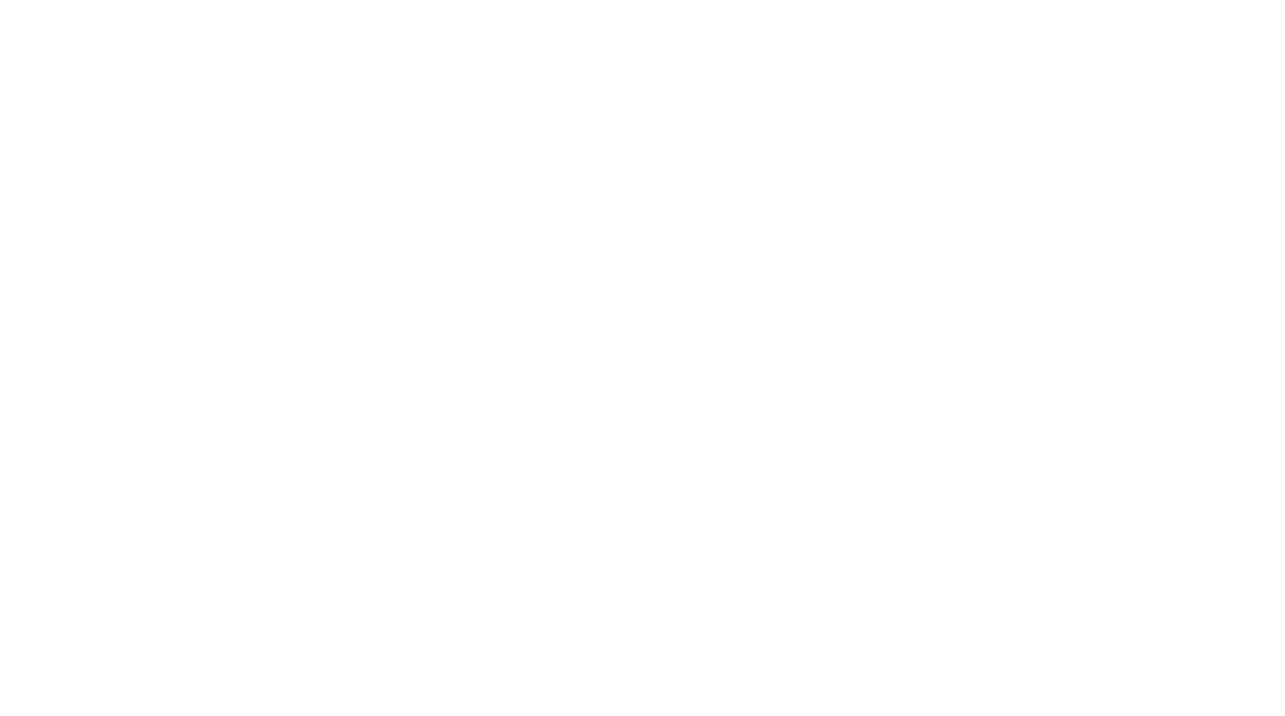
FiGure A2 | Direction selectivity of 20 example cells arbitrarily arranged. (A) Twenty Wfs1 ( + ) neurons. (B) Twenty Pvalb ( + ) cells from layer 2/3. Number against each polar plot denotes maximum scale of the polar plot (in ∆ F / F